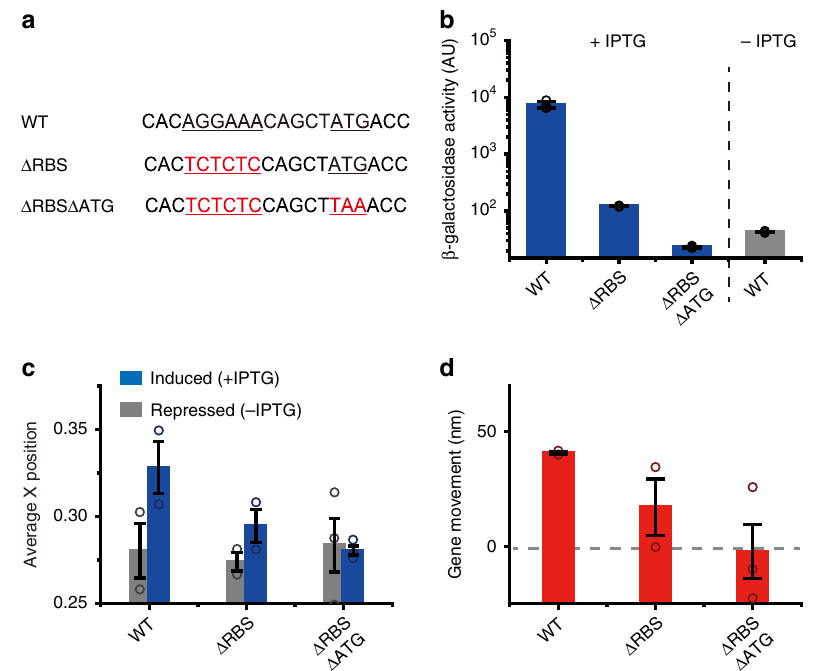
Fig. 4 Translation-dependent gene loci movement toward the nucleoid periphery in E. coli RNAP transcription. a 5 ′ UTR sequence of the mutated strains. The underlined AGGAAA in the WT strain ( lacZ -12xTetO) was mutated to TCTCTC (red letters) ( Δ RBS, lacZ -12xTetO_ Δ RBS) for RBS substitution. The start codon of the lacZ gene (underlined) was mutated to TAA ( Δ RBS Δ ATG, lacZ -12xTetO_ Δ RBS_ Δ ATG). b β -galactosidase assay showing that LacZ expression in the strain in which the start codon in the Δ RBS strain was replaced by a stop codon ( Δ RBS Δ ATG) decreased to ~20% of that in the Δ RBS strain (blue bars, 1 mM IPTG induction of each strain). The LacZ expression level in Δ RBS Δ ATG cells was lower than that in WT cells under repressed conditions (no IPTG, gray bar). c Average x-positions of the lacZ gene locus were determined in the absence (repressed, gray bars) and presence of IPTG (induced, blue bars). d The degree of gene movement is the difference in the average position before (repressed) and after (induced) induction in c . Bar and error bars represent mean ± s.d. from three independent experiments. Each point represents independent